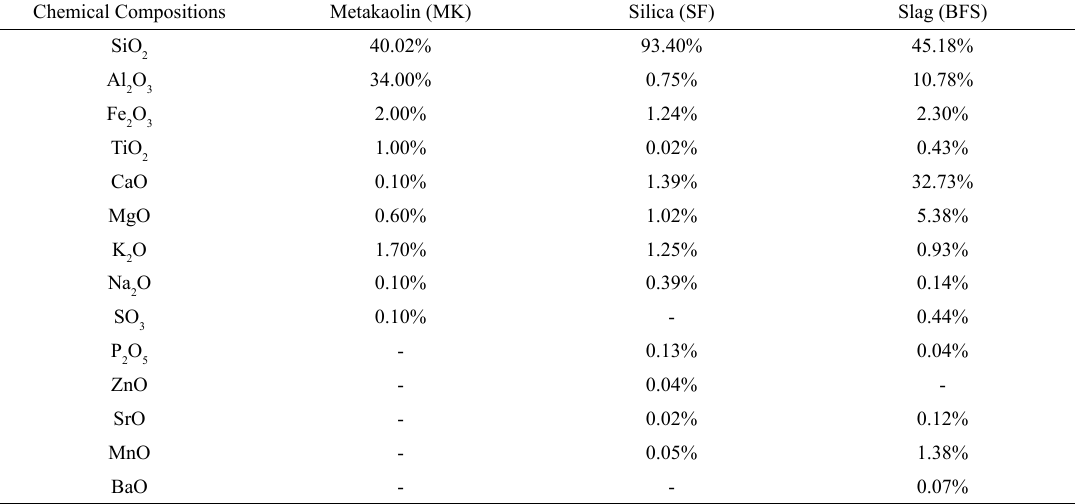
Table 1. Chemical compositions of MK, SF and BFS (by mass).